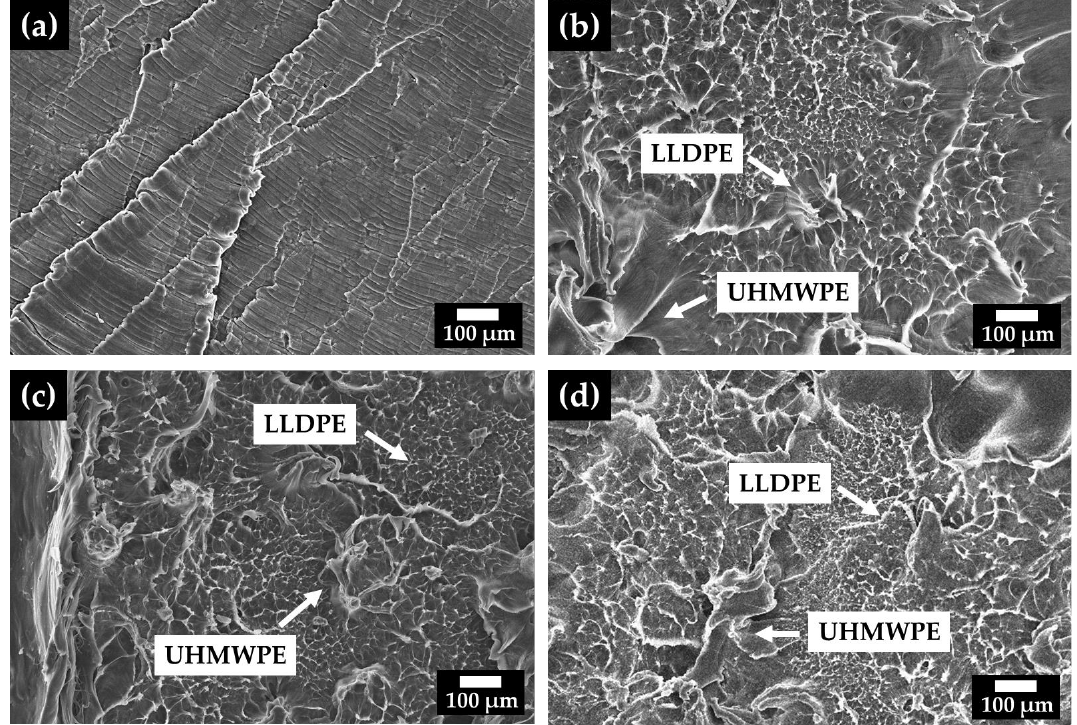
Figure 7. SEM micrographs of the UHMWPE and the blends. ( a ) UHMWPE, ( b ) 15 UHMWPE, ( c ) 30 UHMWPE, and ( d ) 45 UHMWPE.